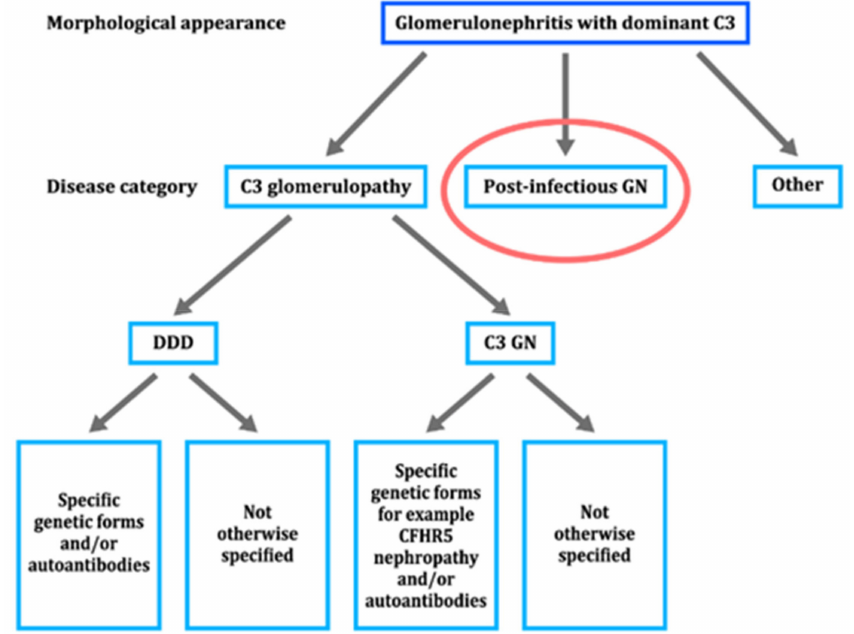
Figure 16. A schematic diagram showing an approach to the classification of disease in a biopsy spec- imen, showing the morphological changes of glomerulonephritis with dominant C3. Post-infectious glomerulonephritis (GN) highlighted by red circle should be differentiated from C3 glomerulopathy. DDD: dense deposit disease, C3 GN: C3